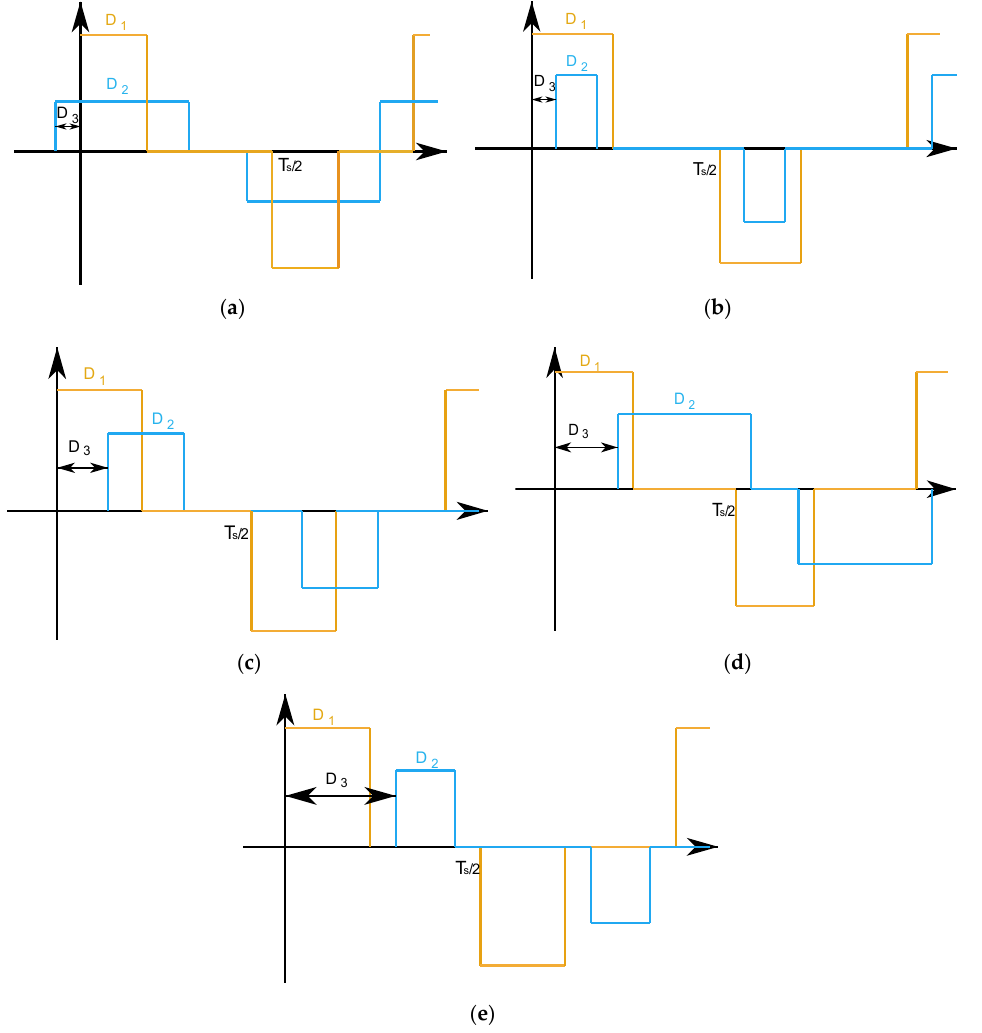
Figure 4. Different operations modes of DAB DC-DC converter in forward/buck case sce- nario: ( a ) mode 1: D 3 ≤ 0; ( b ) mode 2: 0 ≤ D 3 ≤ D 1 , D 2 + D 3 ≤ D 1 ; ( c ) mode 3: 0 ≤ D 3 ≤ D 1 , D 2 +